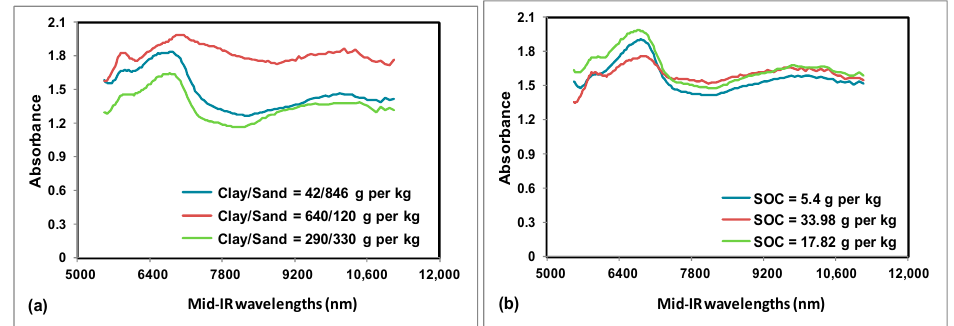
Figure 3. Example of portable mid-IR soil absorbance measurements recorded on selected soil samples. With varying sand and clay ( a ) and SOC content ( b ).